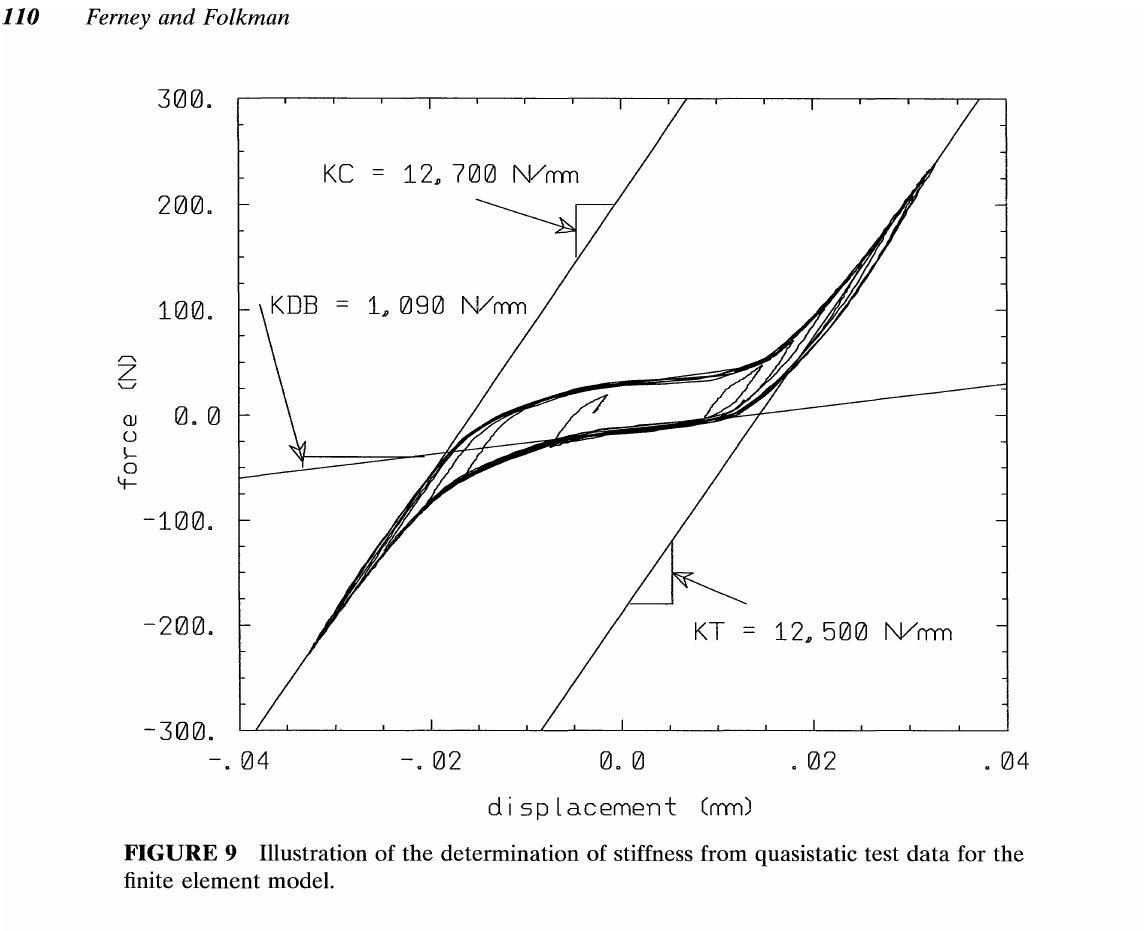
FIGURE 9 Illustration of the determination of stiffness from quasistatic test data for the finite element